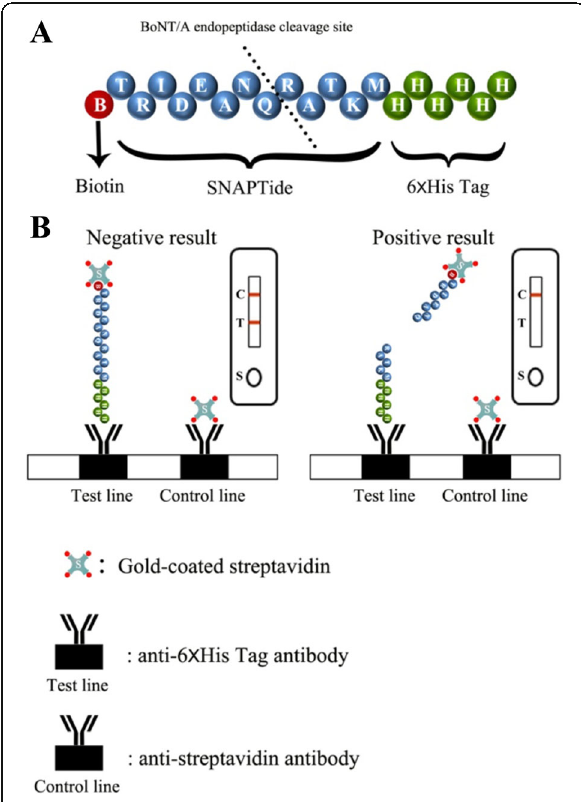
Fig. 1 The diagrammatic representation of the as-prepared LFTS. a The sequence of specific substrate peptide and its cleavage site. b The schematic principle of the LFTS based on the endopeptidase activity of BoNT/A (The inset is the diagrammatic drawing of test results, C : control line; T : test line; S : sample pad)